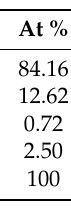
Figure 7. Water contact angle and sliding angle of pulse electrodeposited surfaces as a function of pulse current duty ratio.